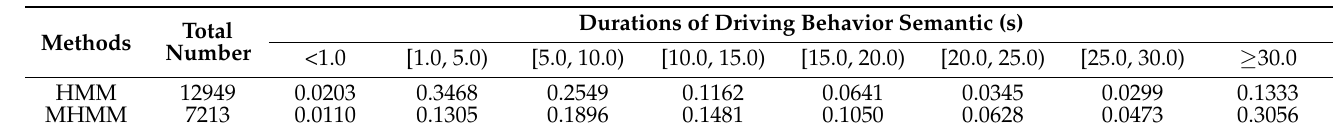
Table 2. Statistical results of the durations of the driving behavior semantic. Durations of Driving Behavior Semantic Total Methods Number